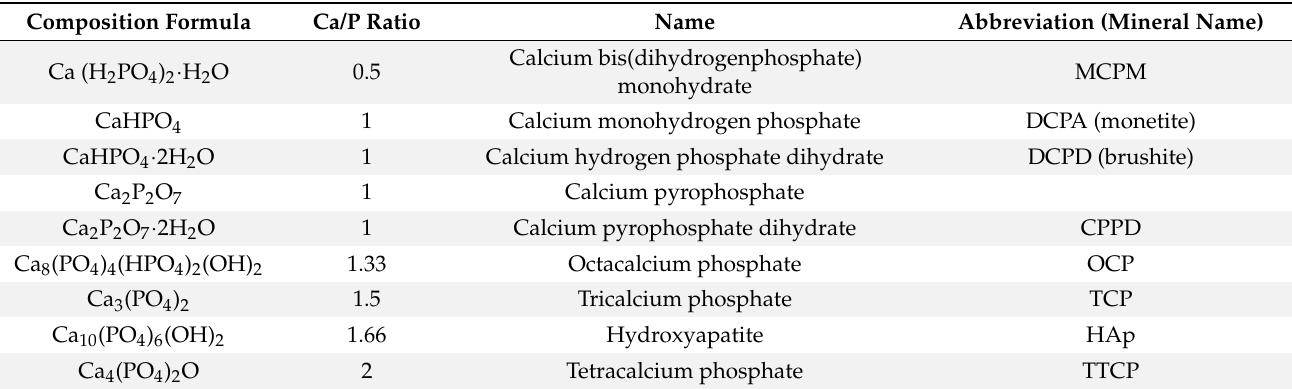
Table 2. A list of the major calcium phosphate